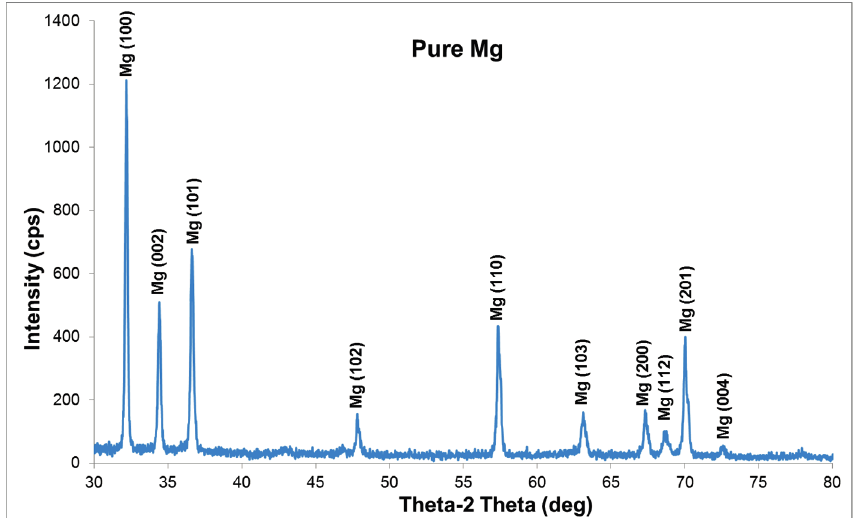
Figure 6. X-ray diffractogram of pure magnesium after microwave sintering.